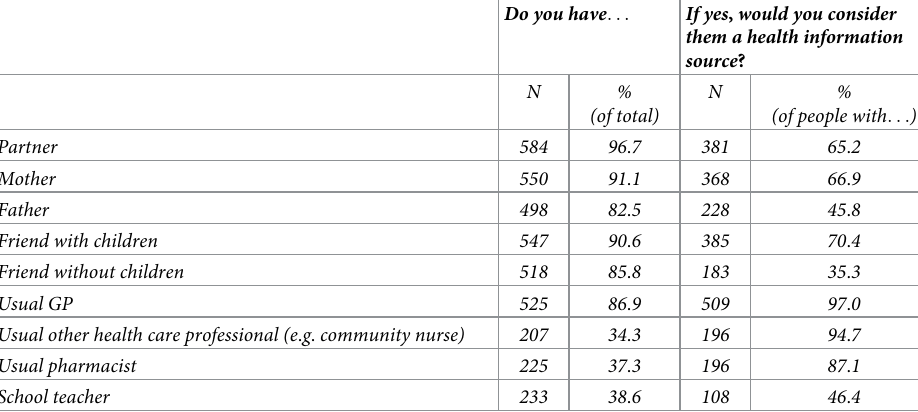
Table 3. Characteristics of the key influencers.